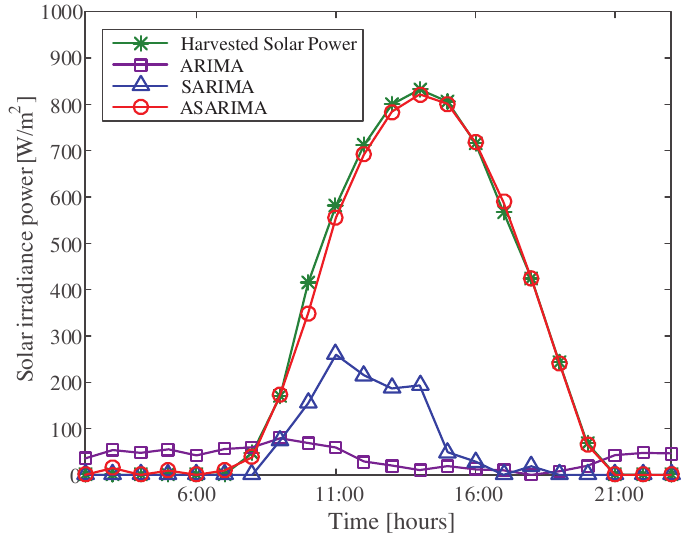
Figure 4. Three time-series model prediction results of 17 April